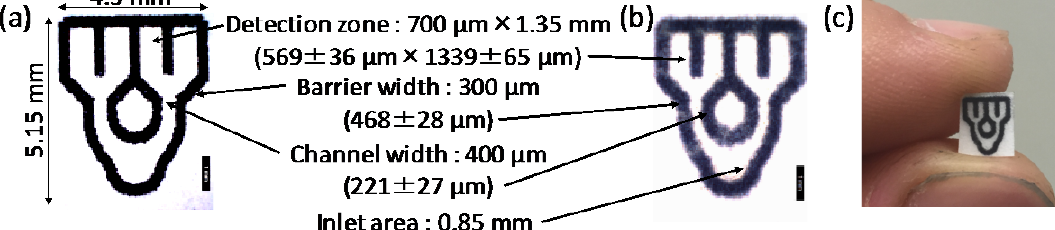
Figure 5. Micrographs of a wax-printed microfluidic paper-based analytical device (µPAD): ( a ) before and ( b ) after hot lamination. The scale bars correspond to a length of 1 mm. Dimensions are indicated before and after hot lamination (values in parentheses). ( c ) Corresponding photograph.